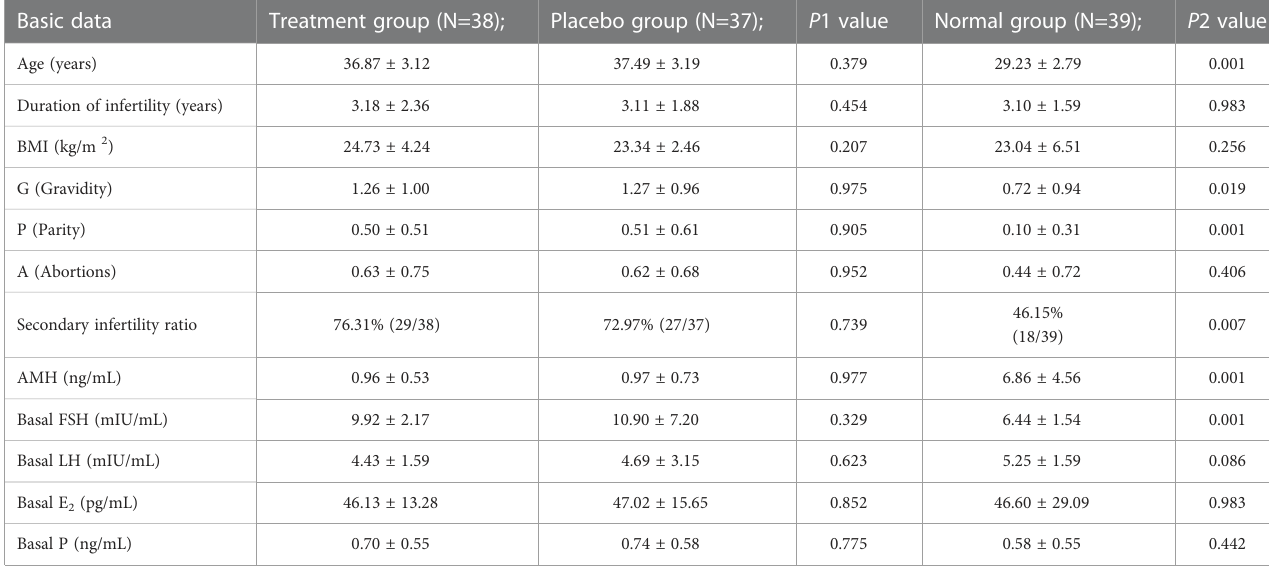
TABLE 1 Comparison of basic data among three groups [( (cid:1) x ± s),%]. Basic